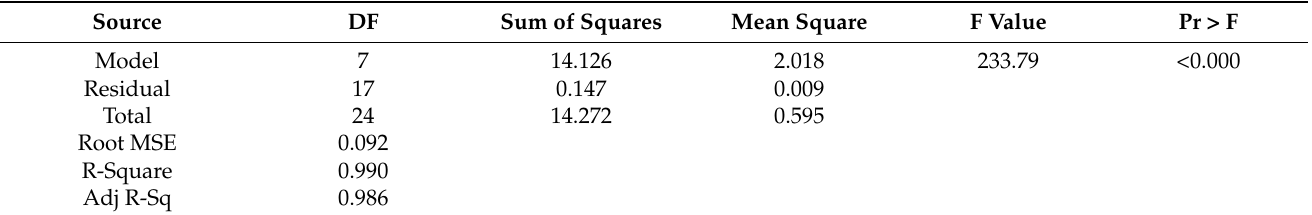
Table 5. Analysis of